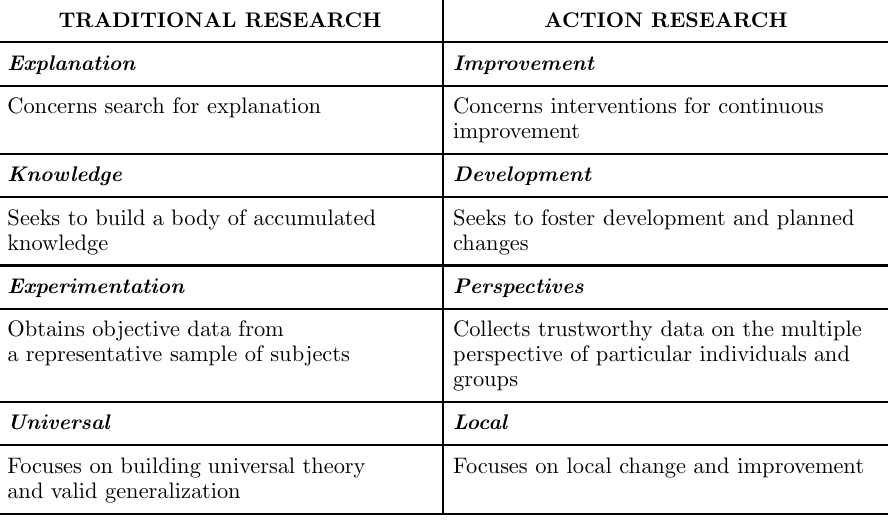
Comparison of two research types (Schmuck 2009: